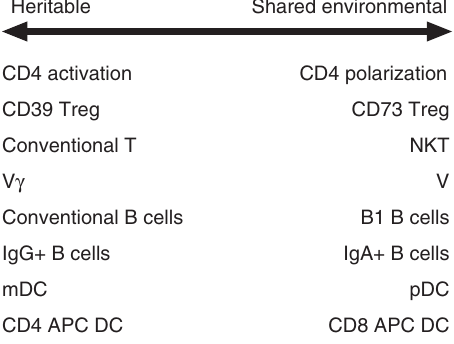
Figure 5 | Influences on leukocyte subset representation. SEqM quantifies the degree of variation in traits that can be ascribed to heritable versus shared environmental influences. Here are illustrated divergent trends in major subsets. For each comparison, the illustration indicates a relative increase in either heritable or shared environmental influences. For example, subsets of CD4 T cells defined by polarization markers (chemokine receptor expression) show increased shared environmental influences compared to C4 subsets defined by activation markers (CD38,